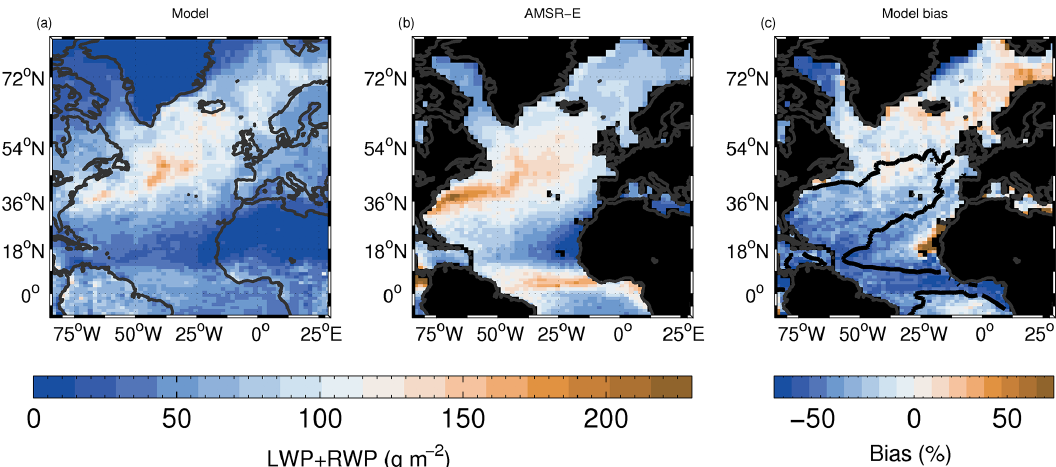
Figure D3. As for Fig. D1 except with the addition of the all-sky rainwater path (RWP) for both the model and AMSR-E satellite data. No filtering for f LWP has been applied.